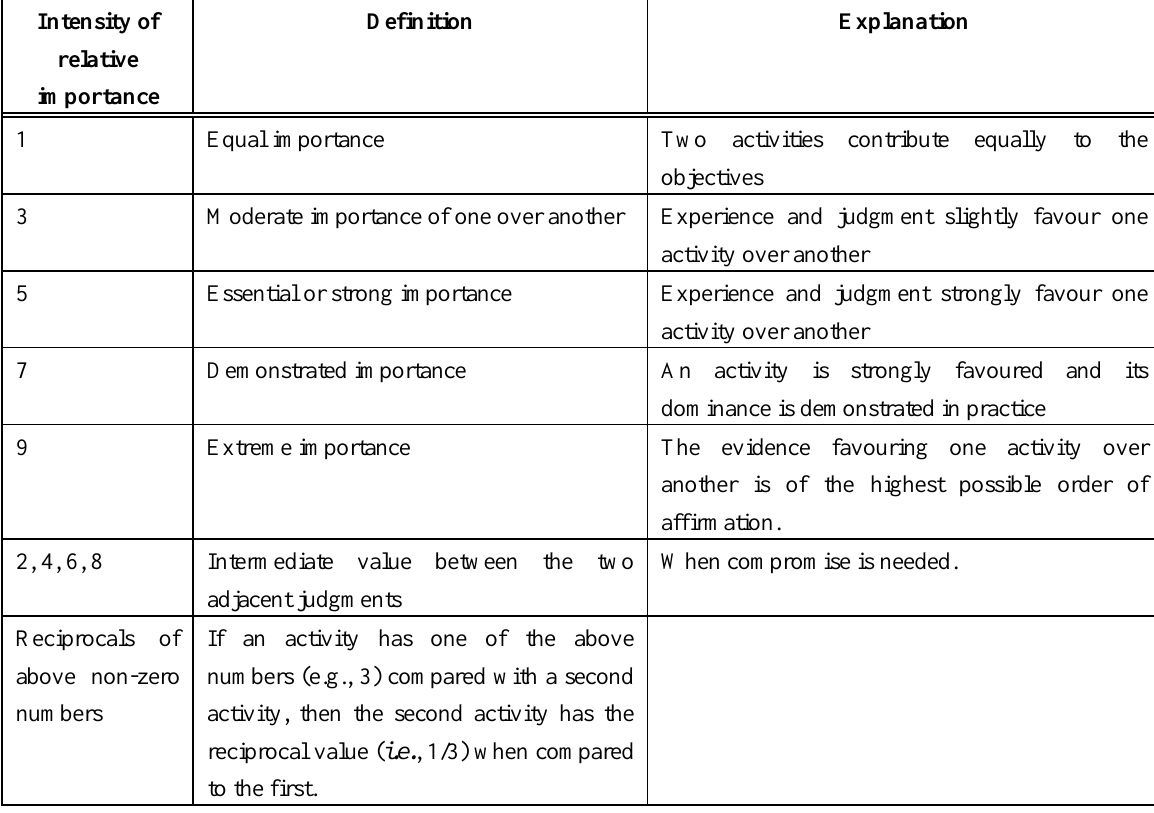
Table 2. Scale of relative